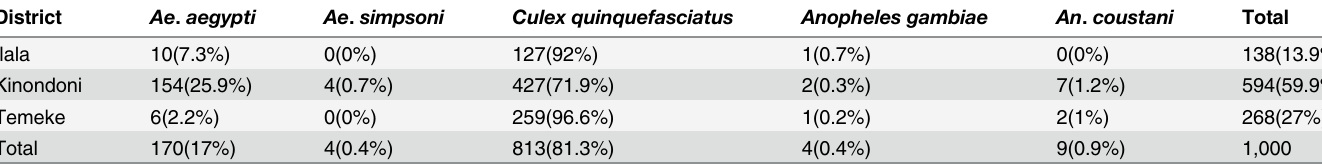
Table 1. Number (%) and species of adult mosquitoes collected by Mosquito Magnet Liberty Plus